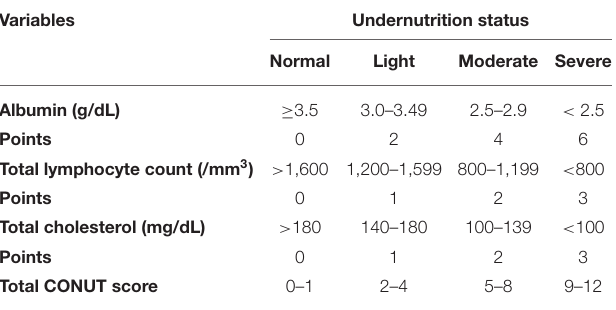
TABLE 1 | Controlling nutritional status score calculation. TABLE 2 | Comparison between the Low- ( < 42.1) and the High-CCI (